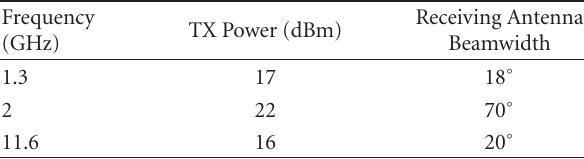
Table 1: Beamwidths of antennas